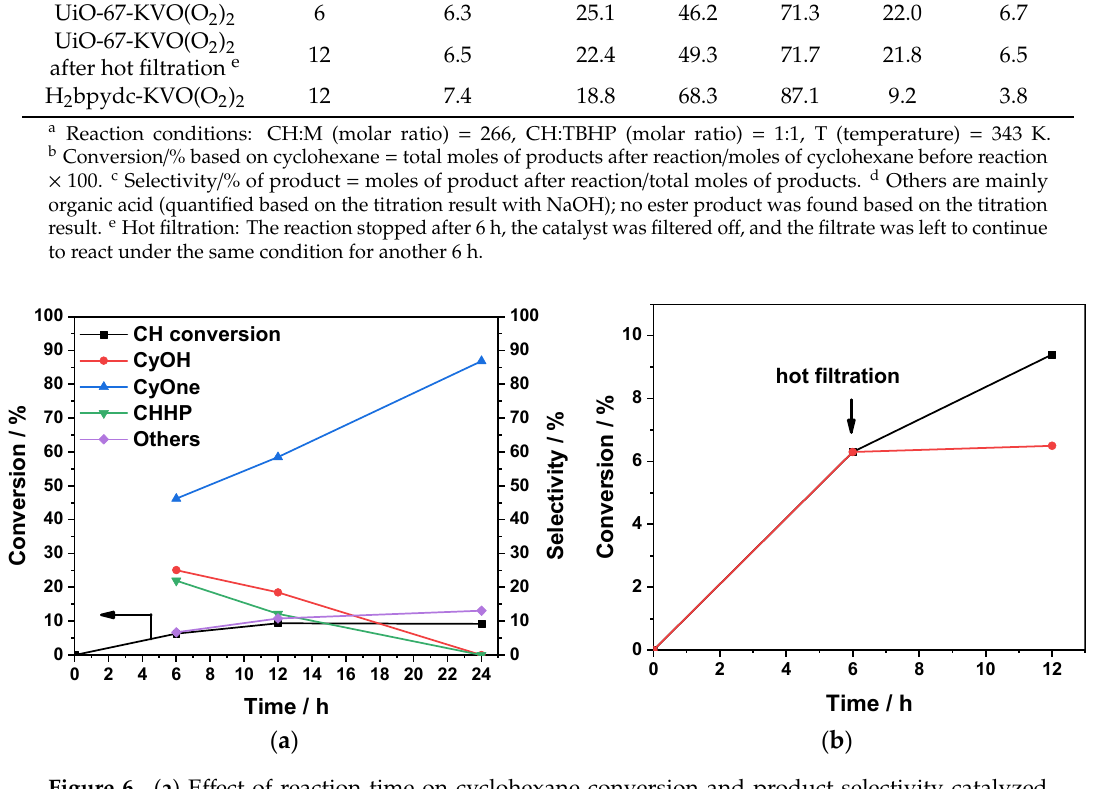
Figure 6. ( a ) Effect of reaction time on cyclohexane conversion and product selectivity catalyzed by UiO-67-KVO(O 2 ) 2 . Reaction conditions: CH:M (molar ratio) = 266, T = 343 K; ( b ) Cyclohexane conversion (%) in the hot-filtration reaction over UiO-67-KVO(O 2 ) 2